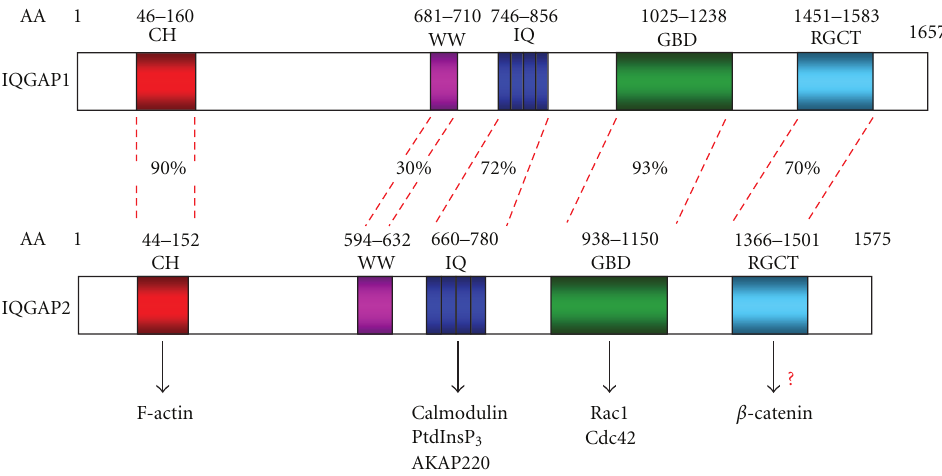
Figure 1: The domain structure of human IQGAP1 and IQGAP2. CH (calponin homology) domain, WW, polyproline binding domain, IQ calmodulin-binding motif, GBD-GTPase binding domain, and RGCT-RasGAP C-terminus domain. Domain percent homology is shown. Adapted from [15, 16]. Also shown binding partners of IQGAP2 identified to date. While it has been confirmed that IQGAP2 co- immunoprecipitates with β -catenin [27], RGCT is marked as a domain responsible for β -catenin binding based on analogy with IQGAP1. A list of IQGAP1 numerous binding partners can be found in